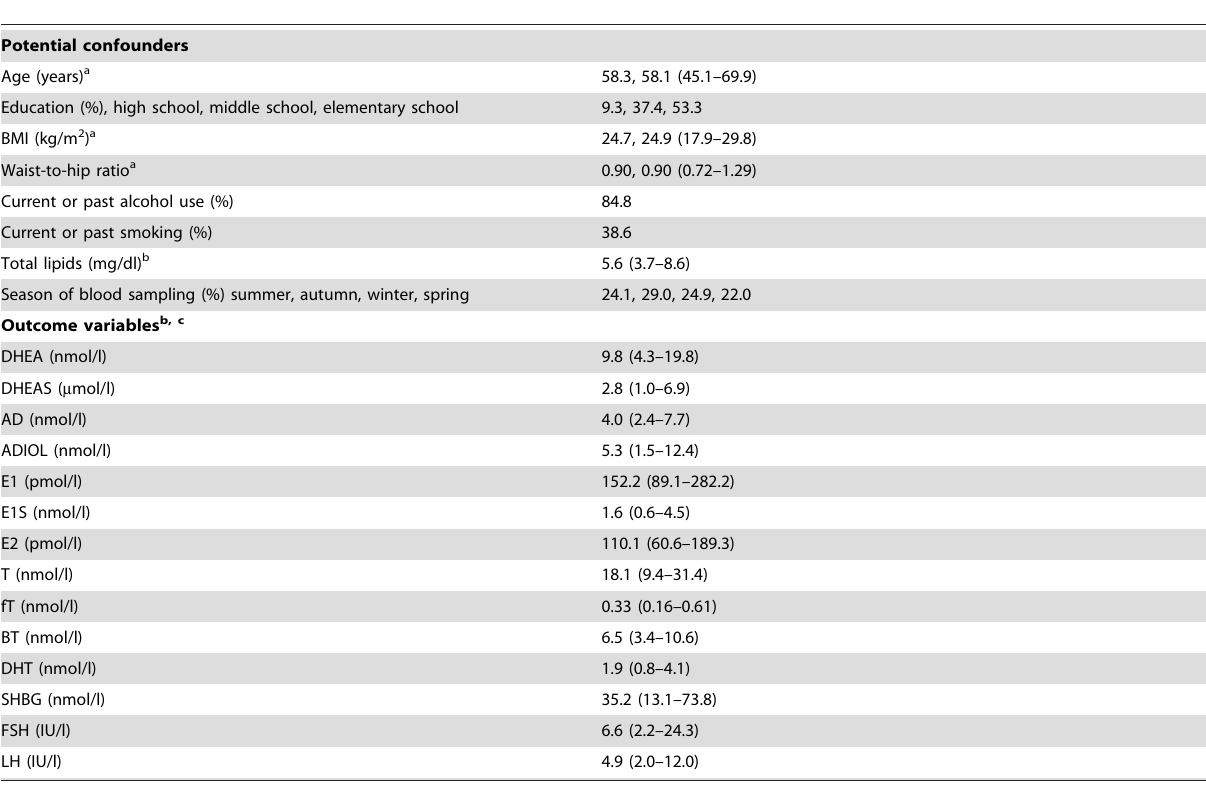
Table 1. Characteristics of the study population in terms of potential confounders and outcome variables.